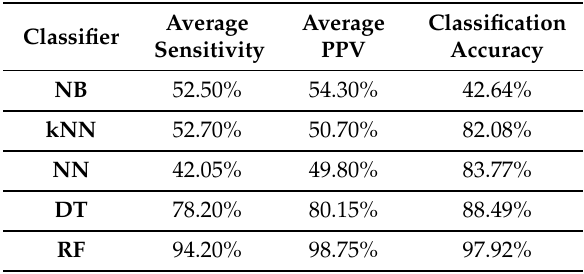
Table 6. Results for the identification of frail subjects